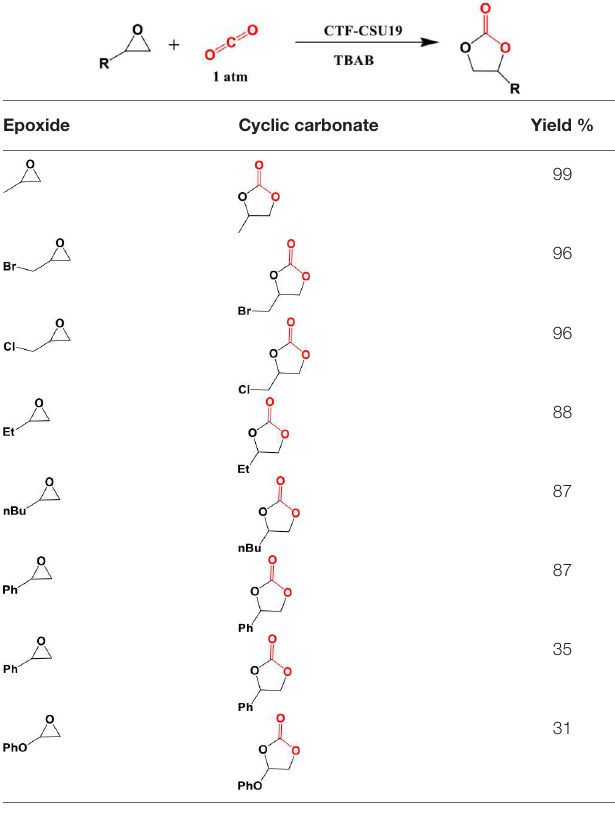
TABLE 4 | Scope of reactions carried out by Yu et al. TABLE 5 | Synthesis of various cyclic carbonates using the 2,3-DhaTph COF